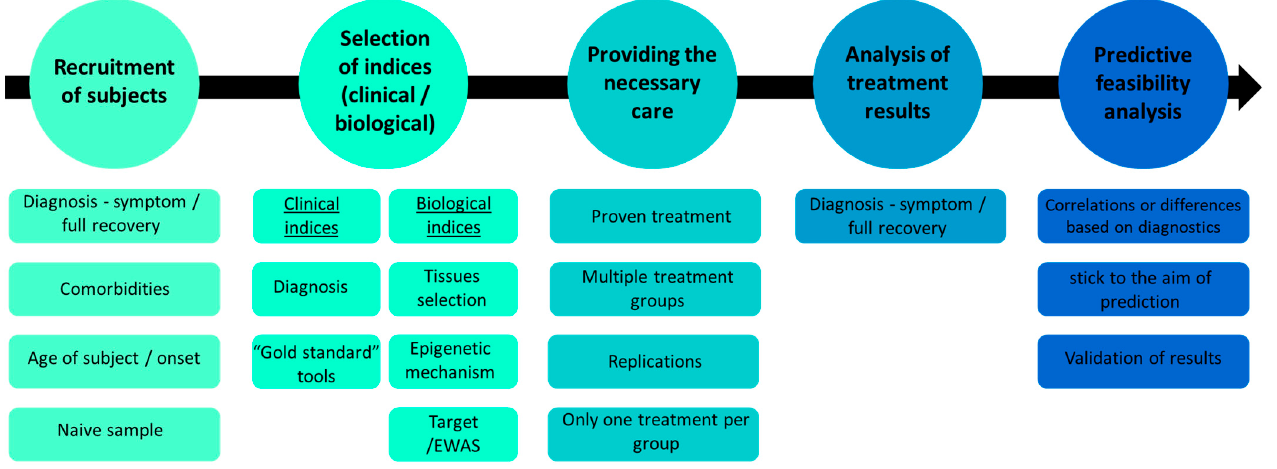
Figure 2. Overview of the proposed experimental design for epigenetic personalized medicine drug discovery, highlighting key stages and considerations.